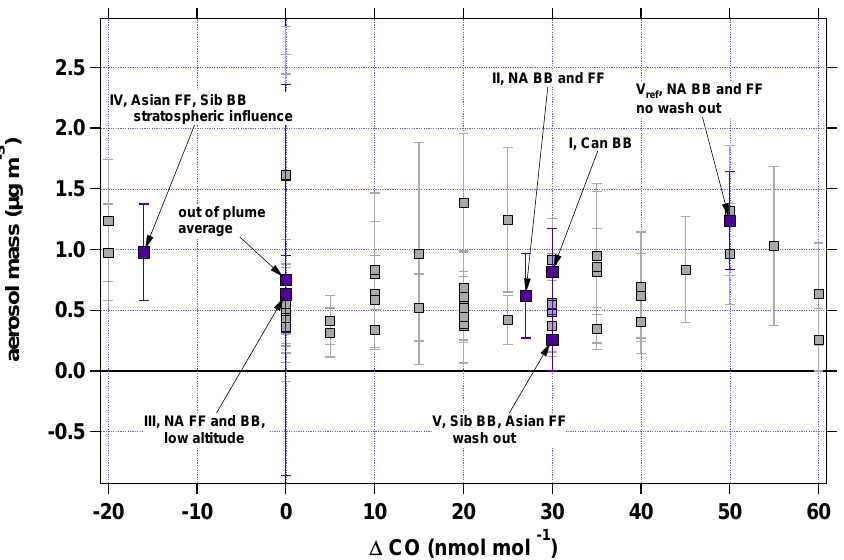
Fig. 12. Total AMS derived aerosol mass versus 1 CO for 48 identified pollution plumes and one average non-plume point. The highlighted plumes are discussed in Sect.